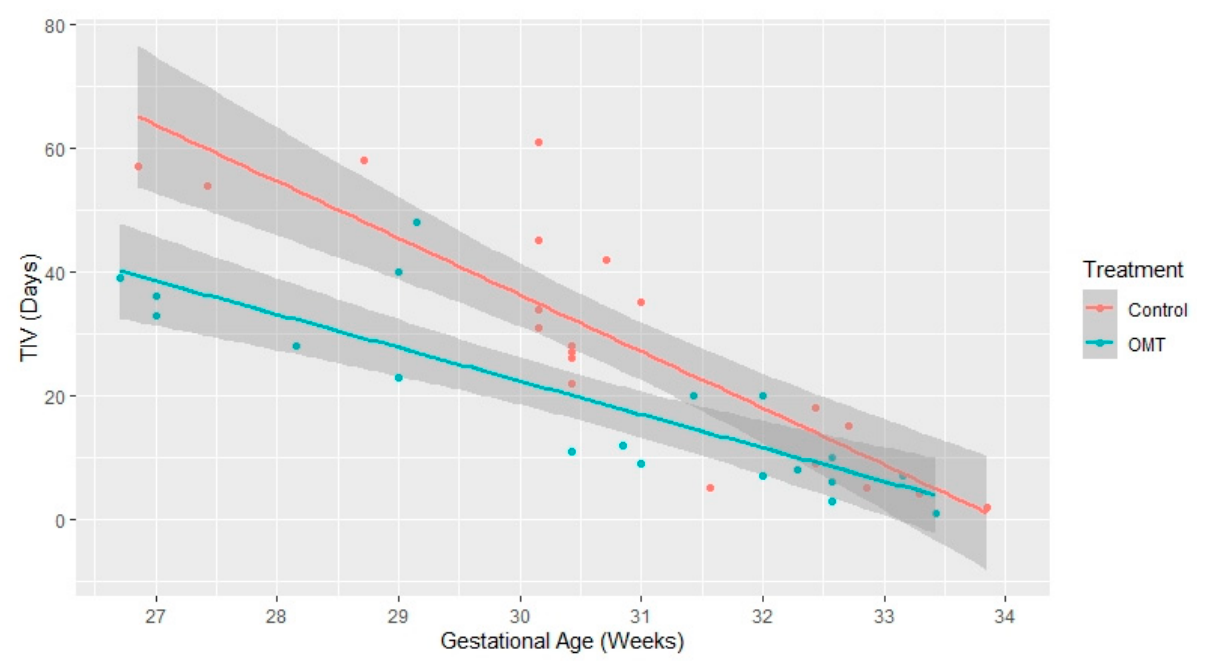
Figure 2. Distribution of ventilation weaning in the function of the gestational age stratified by OMT exposure.